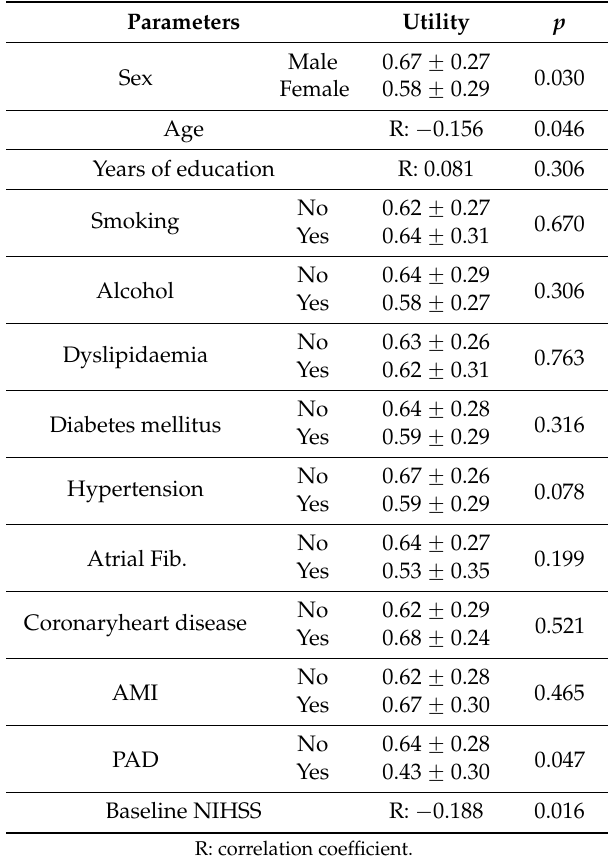
Table 2. Utility according to demographic variables, risk factors, and severity.